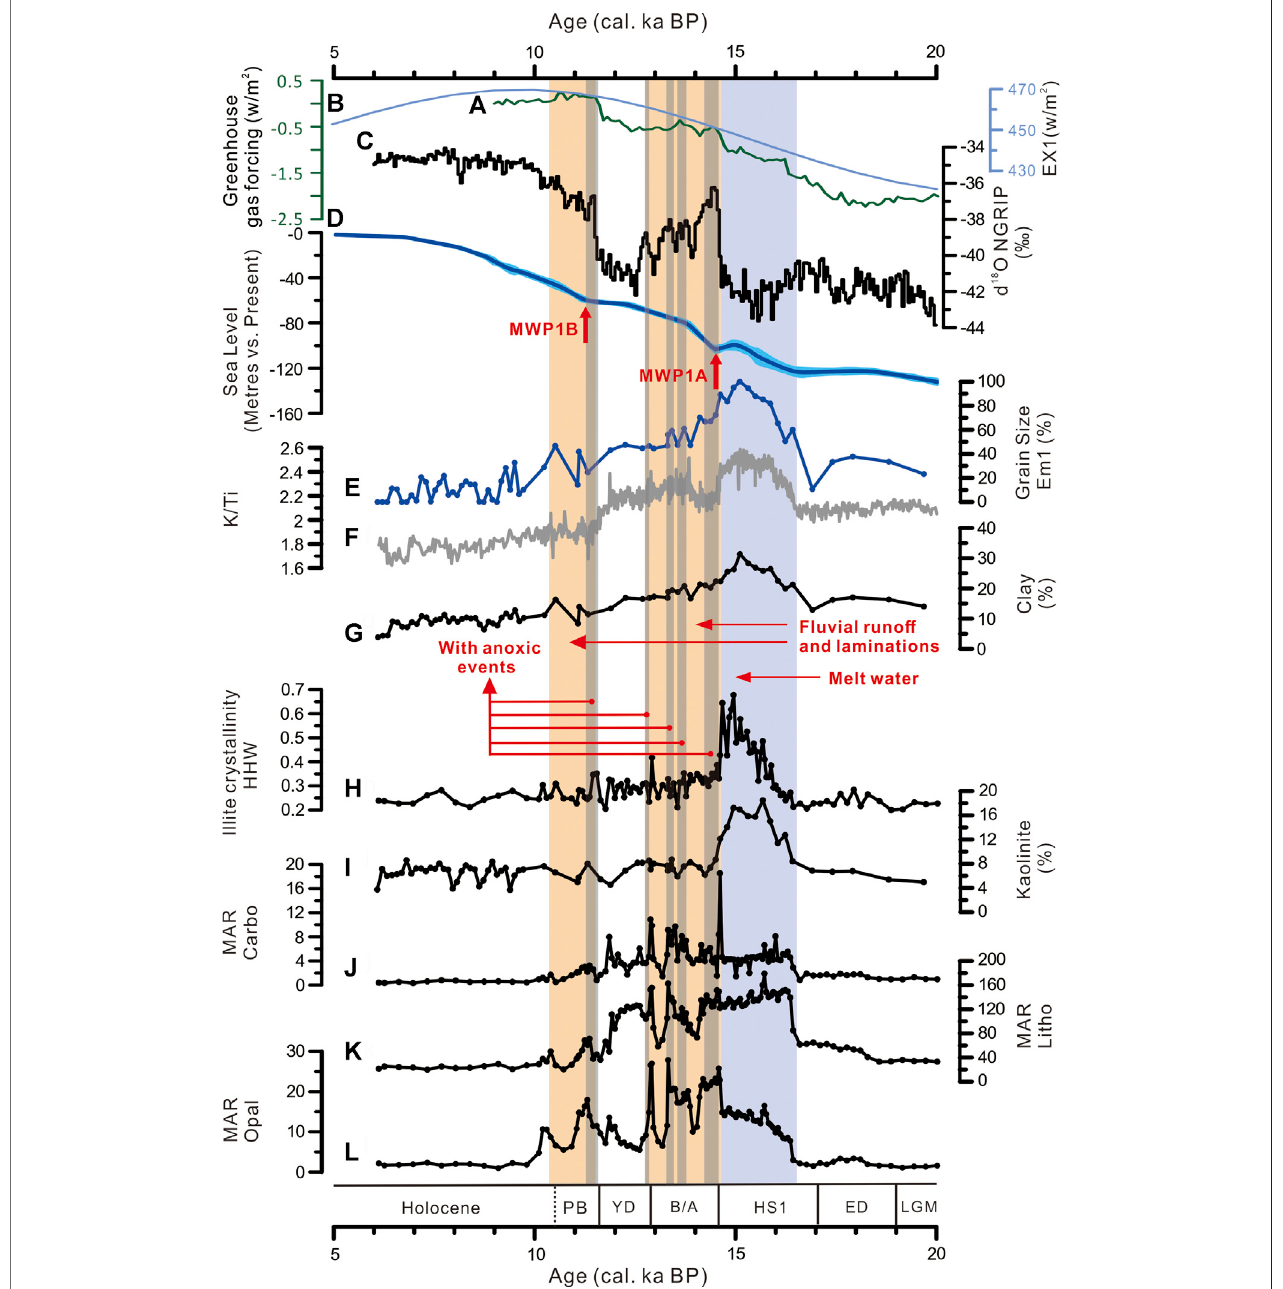
FIGURE 4 | Paleoenvironmental indicators (A – D) compared with the deglacial proxy record (E – L) of the composite section of sediment cores SO202-18-3/-6: (a) insolation forcing at 65 ° N (Berger and Loutre, 1991); (b) greenhouse gas forcing (Marcott et al., 2014); (c) the oxygen isotope record of the Greenland NGRIP ice core (Andersenet al.,2004);(d)theglobal sea-levelcurve (Lambecket al.,2014);(e,f,g)loadingofgrain-sizeend member 1,theK/Tiratio,andclayproportionsasproxiesof fl uvialrunoff;(h,i)illitecrystallinity(HHW)andkaoliniteproportionasindicatorsofprovenancechangeduringlateHS1;(j,k,l)mass-accumulationrates(MAR,g/cm 2 / ka) of carbonate (Carbo), terrigenous sediment supply (litho), and biogenic opal. The blue shade marks the timing of the glacio fl uvial melt-water pulse during late HS1. Light brownish shades indicate periods of high biological productivity with dark brown shades in conjunction with laminite preservation and anoxic events (Kuehn et al., 2014).